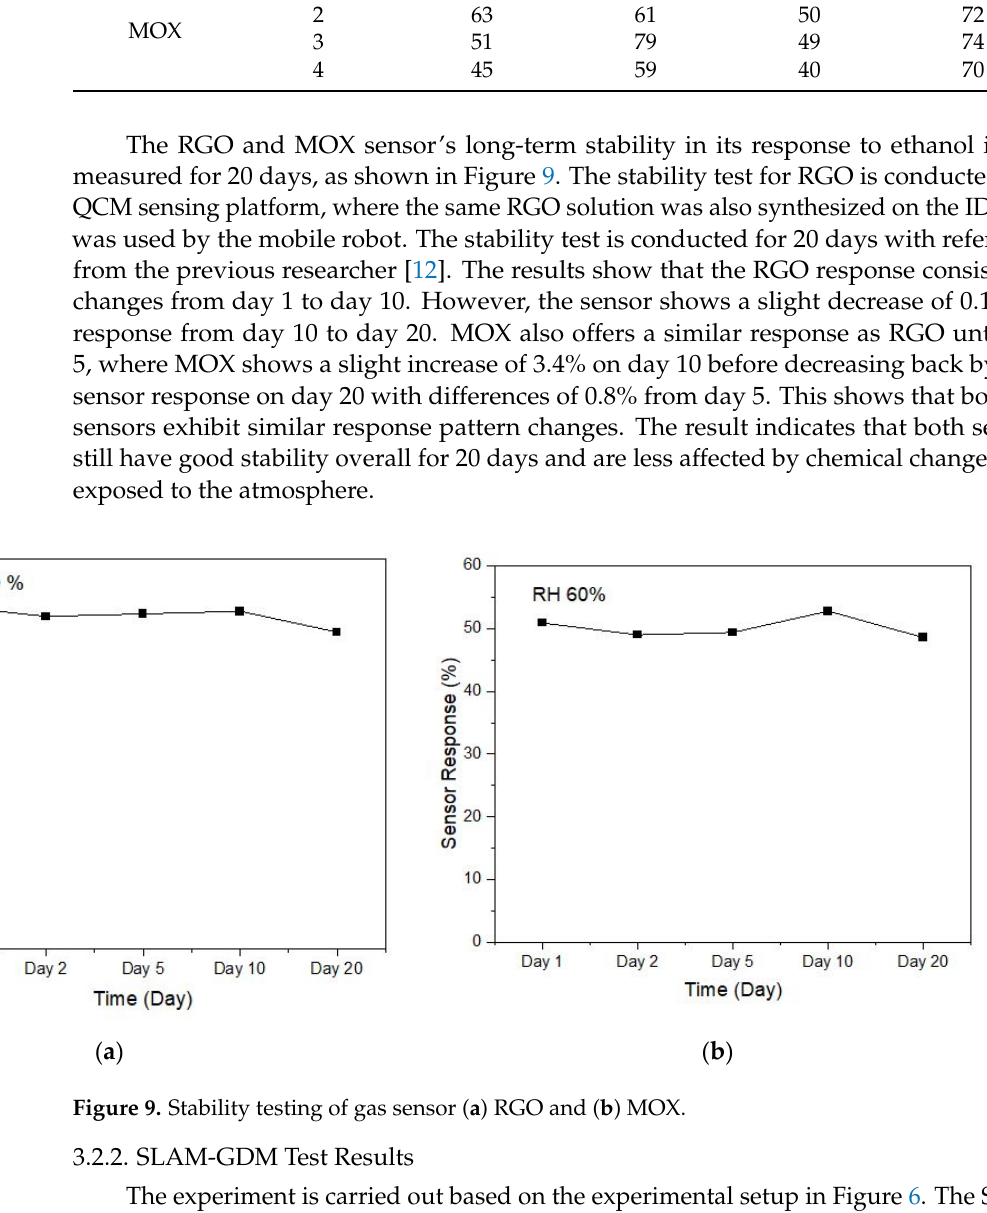
Table 2. Mean gas concentration SLAM-GDM Map with actual and predicted gas source location.